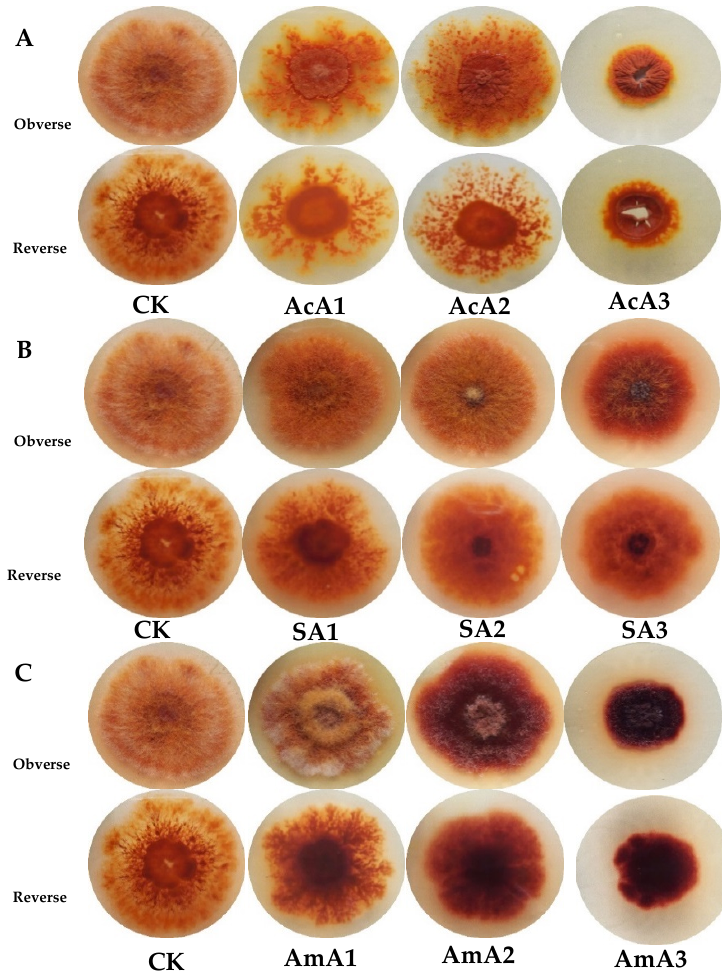
Figure 1. Colonial morphologies of Monascus ruber M7 grown on PDA spiked with ( A ) acetic acid (AcA), ( B ) sodium acetate (SA), ( C ) ammonium acetate (AmA) at different concentrations. ( A ) AcA1: 0.1%, AcA2: 0.25%, AcA3: 0.5%; ( B ) SA1: 0.1%, SA2: 0.25%, SA3: 0.5%; ( C ) AmA1: 0.1%, AmA2: 0.25%, AmA3: 0.5%; CK: Control.3.2 The Effects of Acet ic Species on Biomasses of M. ruber M7 .